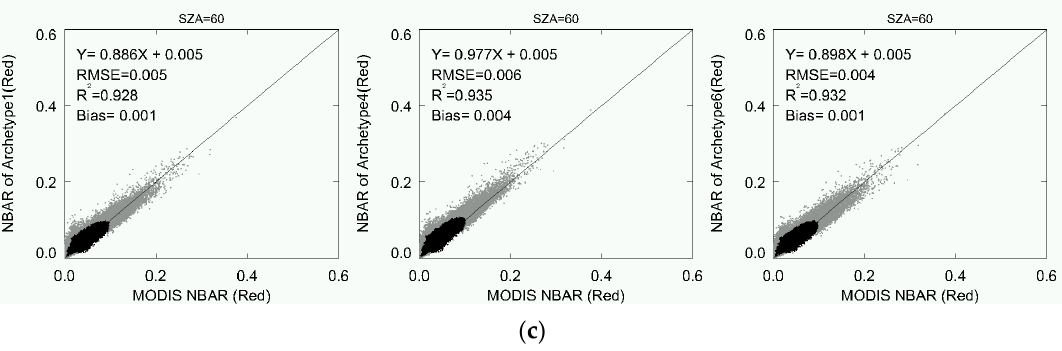
Figure 8. Comparison of the MODIS NBARs and NBARs retrieved from different archetypal BRDFs in the red band. The black points account for 95% of all selected data. ( a – c ) refer to the result at solar zenith angle of 15°, 40°, and 60°. Three columns represent the result of archetypal BRDF Nos. 1, 4, and 6.